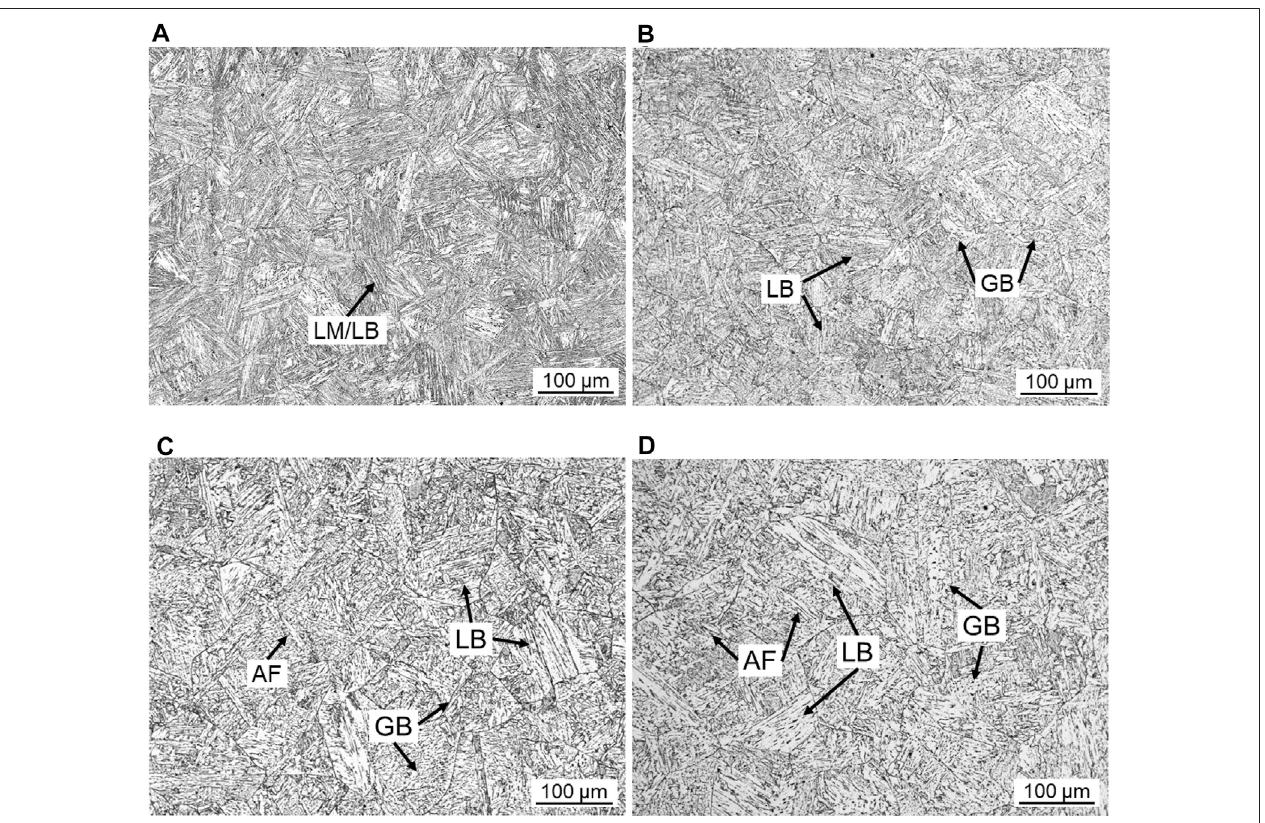
FIGURE 3 | Optical micrographs of the microstructures in the CGHAZ at the heat inputs of (A) 50, (B) 100, (C) 150, and (D) 200 kJ/cm.